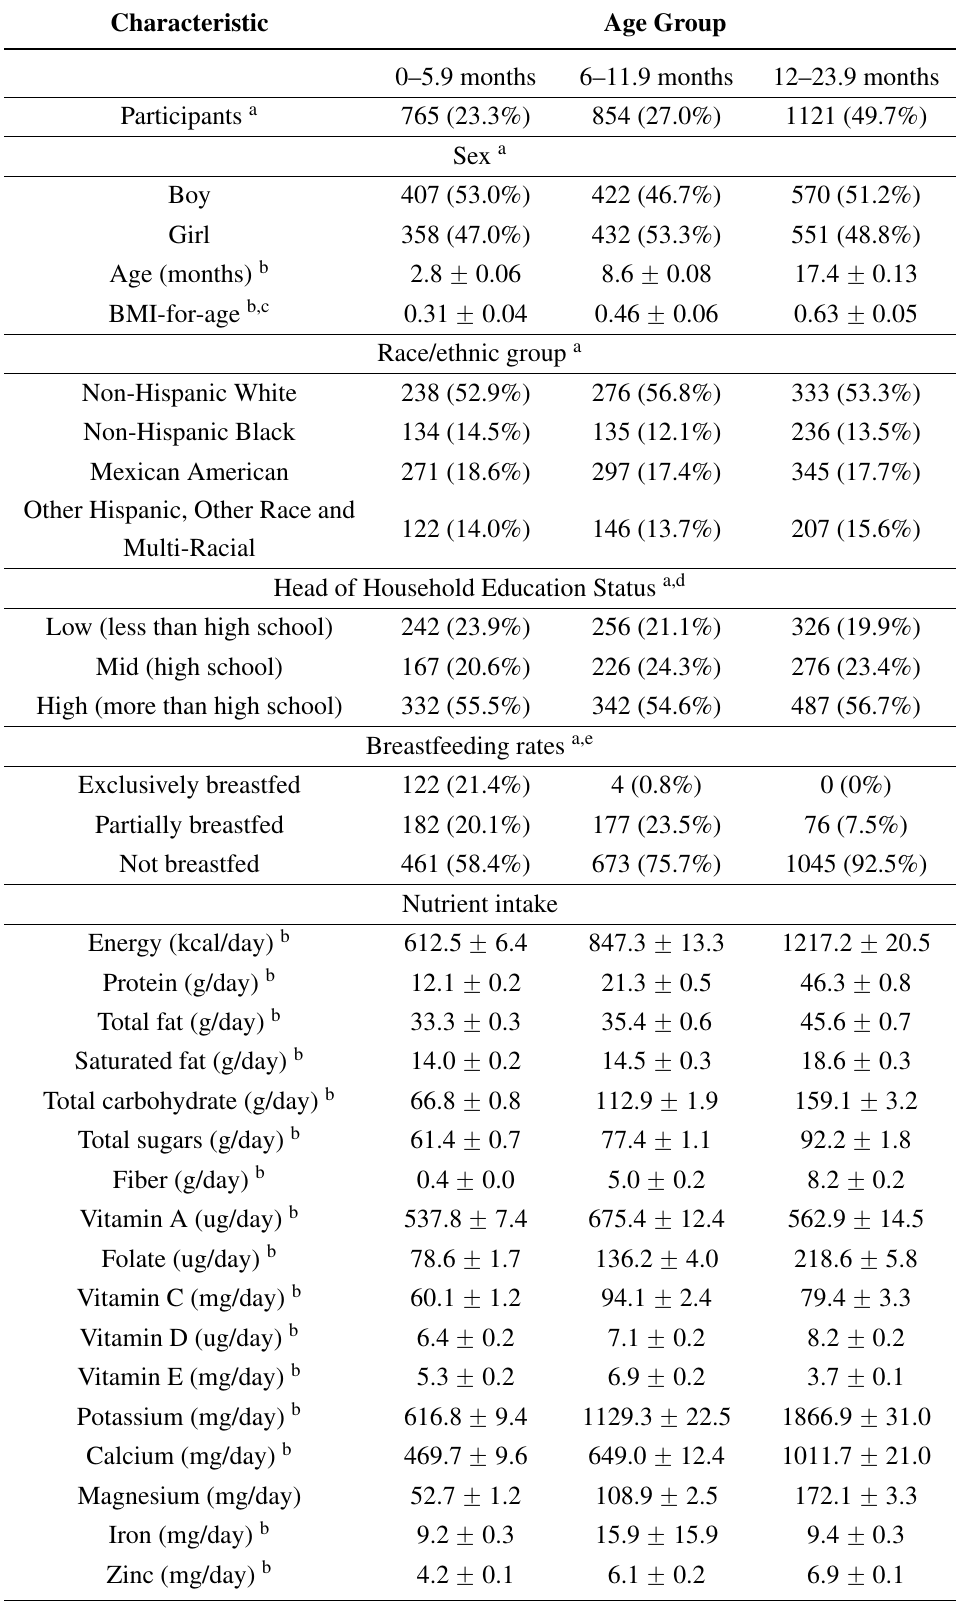
Table 1. Demographic characteristics and nutrient intake in U.S. infants and toddlers